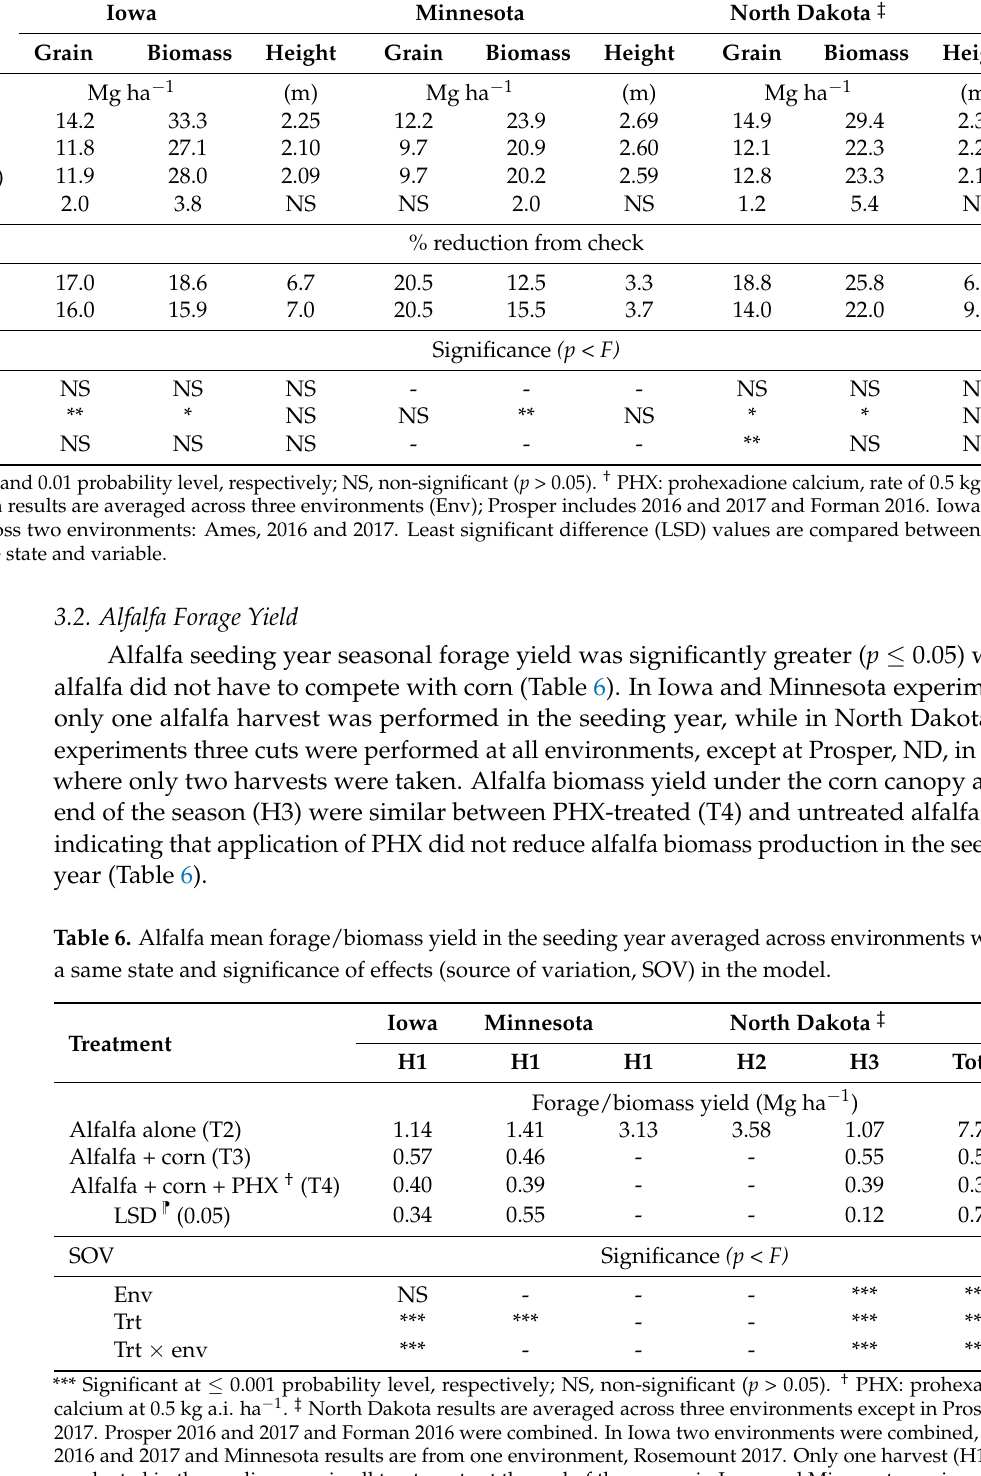
Table 5. Corn grain yield, above-ground biomass yield, and plant height means for each treatment and significance of effects (source of variation, SOV) in the model averaged across locations within a state. Iowa Minnesota North Dakota ‡ Treatment Grain Biomass Height Grain Biomass Height Grain Biomass Height Corn alone (check, T1)